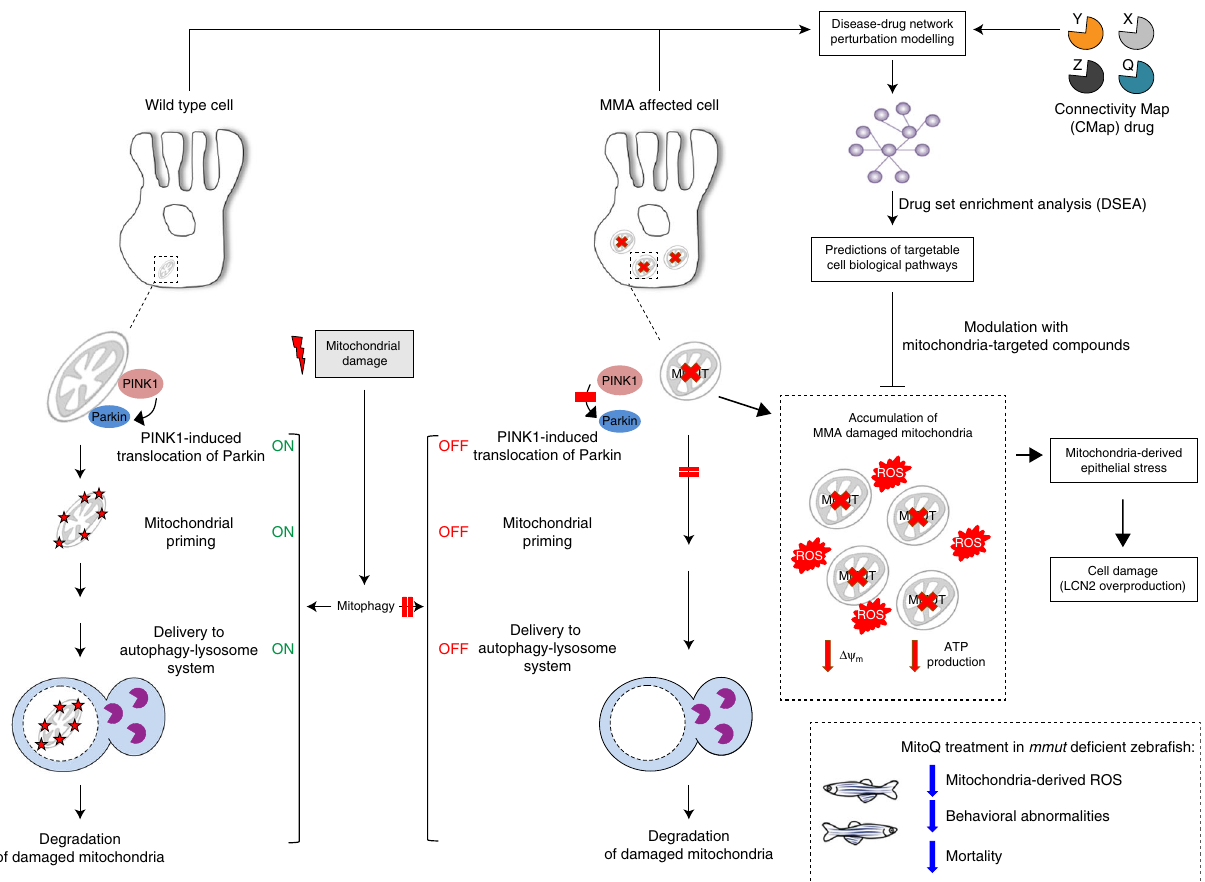
Fig. 10 Proposed model depicting the link between mitochondrial dysfunctions and epithelial stress in MMA. In wild-type kidney cells (left), mitochondrial stress (e.g. treatment with Rotenone) stimulates PINK1-induced translocation of Parkin to damaged mitochondria. This triggers mitophagy and the subsequent disposal of dysfunctional mitochondria through autophagy – lysosome degradation systems, thereby safeguarding the homeostasis and function of the mitochondrial network. By contrast, in MMA-affected kidney cells (right), the impaired PINK/Parkin-mediated mitophagy impedes the delivery of damaged mitochondria and their degradation by autophagy ‒ lysosome pathways. This leads to accumulation of MMA-diseased mitochondria and exacerbates the mitochondrial alterations induced by MMUT de fi ciency, including accumulation of toxic metabolites, collapsed mitochondrial membrane potential ( Δψ m ), and abnormal energetic pro fi ling and increased mitochondrial ROS. These mitochondrial alterations generate epithelial stress, causing ultimately cell damage (e.g. LCN2 overproduction). Drug – disease network perturbation modelling, based on transcriptome-wide pro fi les from MMA patient-derived kidney cells against a large compendium of gene signatures derived from 1309 small bioactive drug compounds, identi fi es targetable disease-relevant cell biological pathways. The modulation of the identi fi ed targets (e.g. treatment with mitochondria-targeted ROS scavengers MT or MitoQ) repairs mitochondrial dysfunctions, neutralizes epithelial stress and cell damage in MMA cells, and improves disease-relevant phenotypes in mmut – de fi cient zebra fi LC3-I to LC3-II, with increased autophagosome-associated LC3 + puncta as well as CLEM and/or EM structures compatible with